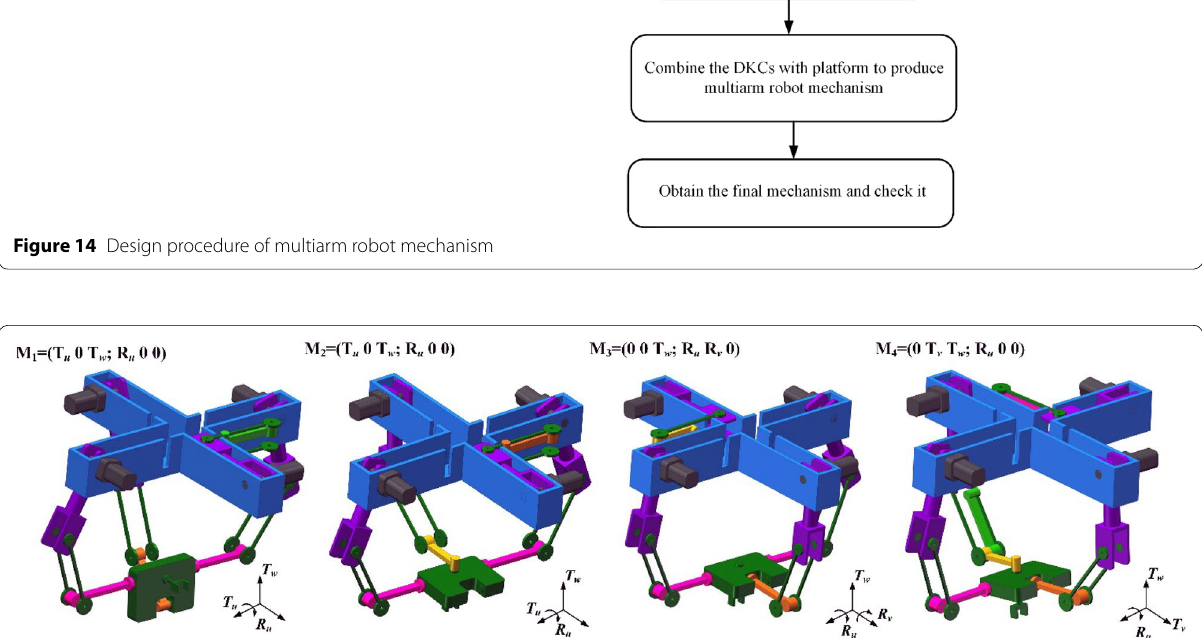
Figure 15 Four working modes of the Type‑I